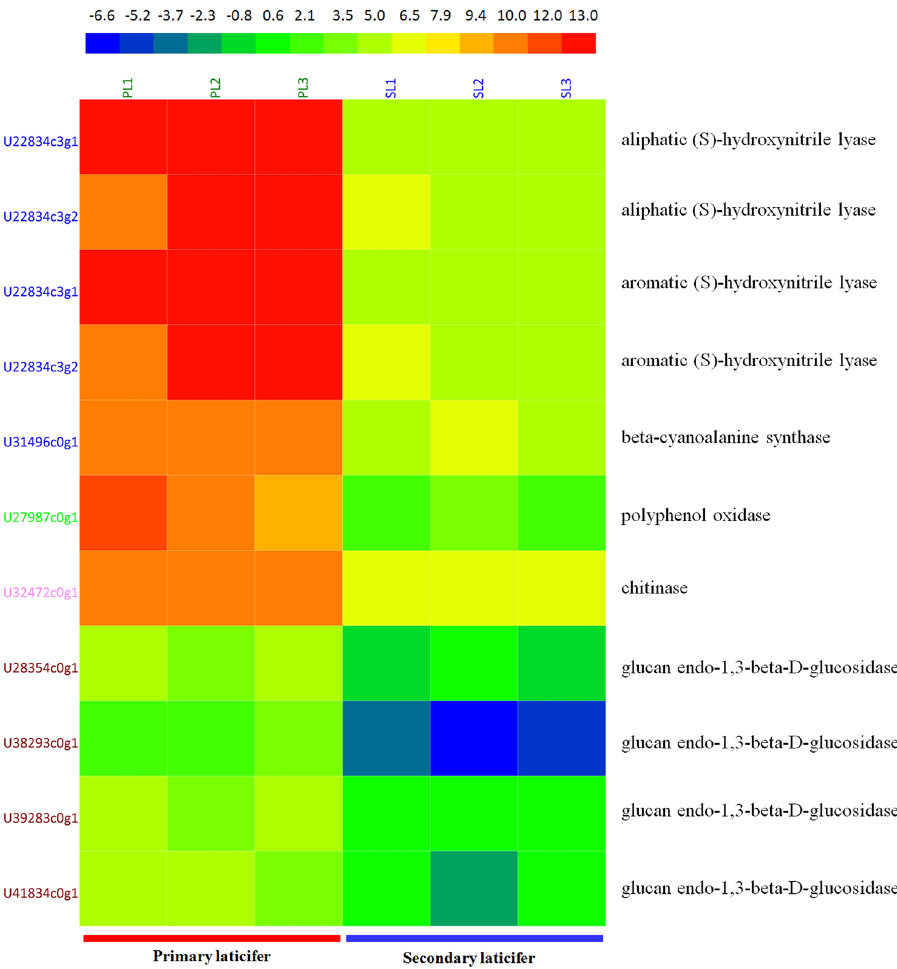
Figure 5. Heatmap of DEGs involved in biotic stresses. The expression levels of DEGs in TPM were compiled with Excel 2007, normalized using a log2 base method, and exported to the HemI toolkit 124 . The Heatmap was generated using the default parameters. The expression levels are presented in different colors, and the values are defined in the scale bar. PL, the primary laticifers; SL, the secondary